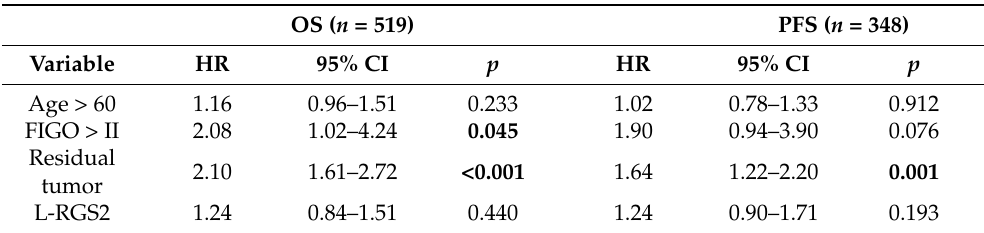
Table 2. Multivariate Cox regression model for OS and PFS in HGSOC patients with re- gard to immunohistochemical RGS2 protein expression in tumor cells and other factors with univariate